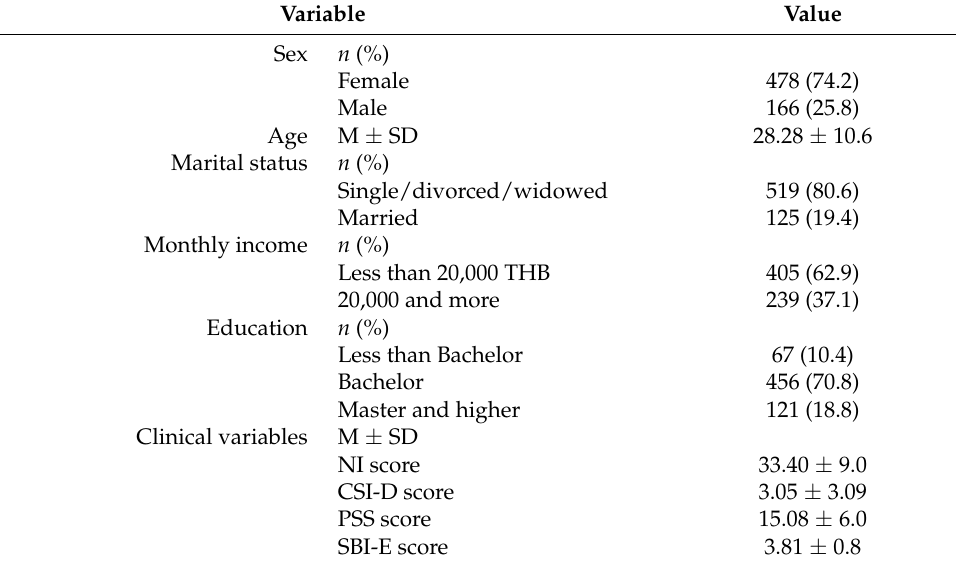
Table 1. Socio-demographic characteristics of the participants ( n = 644).